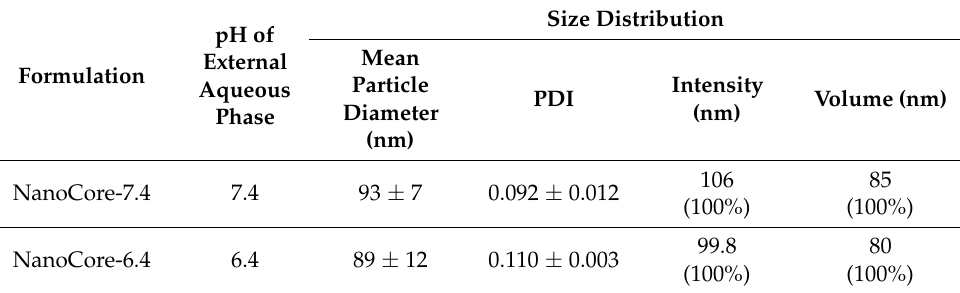
Table 2. Physicochemical properties of the NanoCore-7.4 and NanoCore-6.4 before freeze-drying ( n = 3, mean ± standard